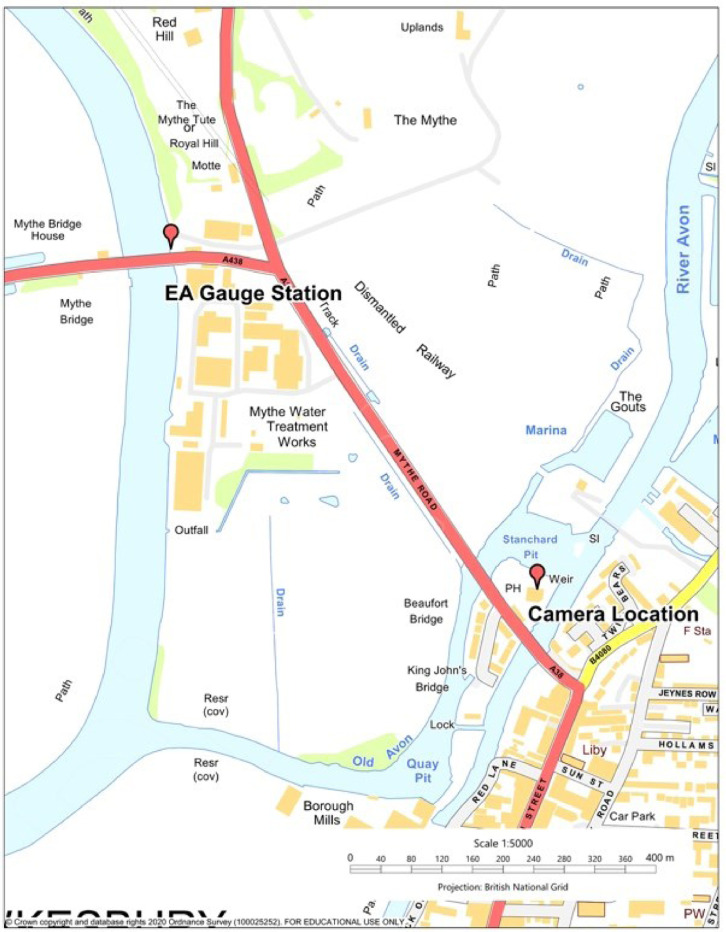
Map illustrating Tewkesbury camera on river Avon and nearest EA river gauge 'Mythe Bridge’ (labelled red teardrop shape markers). The map projection is British National Grid and the map scale is given in the bottom right. The vertical is aligned with true North. Produced using EDINA Digimap Ordnance Survey Service, Date created: 09/03/2020. (For interpretation of the references to colour in this figure legend, the reader is referred to the web version of this article.)